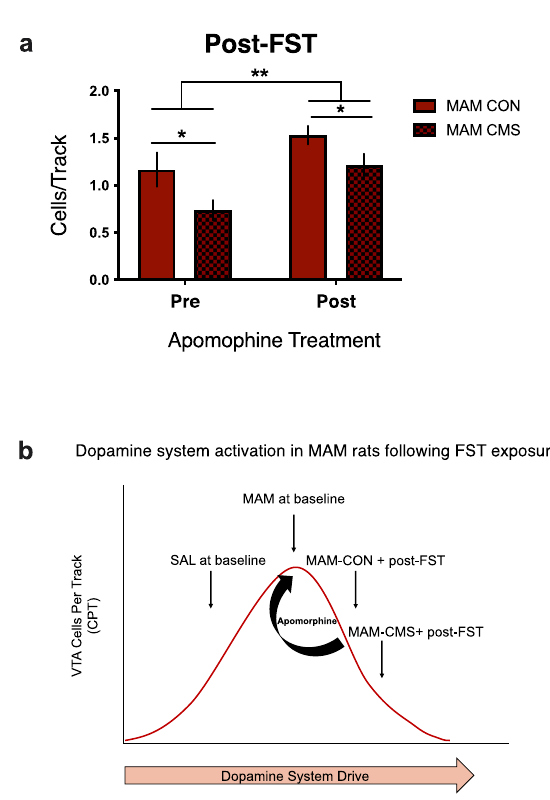
Fig. 4 FST exposure eliminates increased VTA population activity in MAM rats compared to SAL rats. a At baseline, MAM-CON rats exhibited elevated numbers of DA cells/track compared to SAL-CON and both CMS groups (two-way ANOVA: main effect of MAM ( p < 0.01) and adult CMS ( p < 0.0001), n = 6 – 9 per group). b After FST and AIH exposure, there was no difference between SAL and MAM rats in both CON and CMS conditions, although both SAL-CMS and MAM-CMS rats exhibited blunted VTA population activity compared to SAL-CON and MAM-CON rats (two-way ANOVA; main effect CMS: p < 0.01; n = 7 – 9). c Post-FST only, both CMS groups (SAL-CMS, MAM-CMS) exhibited blunted VTA population activity compared to CON groups (SAL-CON, MAM-CON (two-way ANOVA; main effect CMS: p < 0.0001; n = 9 – 11). d At baseline, population activity was reduced along the medial tracks of the VTA in MAM-CMS rats compared to MAM-CON rats ( p < 0.05). e Post- FST and AIH, population activity was reduced along the central tracks of the VTA in MAM-CMS rats compared to MAM-CON rats ( p < 0.01). f Post-FST only, population activity was reduced along the central tracks of the VTA in SAL-CMS rats compared to SAL-CON rats ( p < 0.05). g No effect of MAM ( p = 0.31) or CMS ( p = 0.68) was found for fi ring rate at baseline. h No effect of MAM ( p = 0.71) or CMS ( p = 0.43) was found for fi ring rate post-FST and AIH. i Post-FST only, there was no effect of MAM ( p = 0.14) or CMS ( p = 0.58) for fi ring rate. j At baseline, no effect of MAM ( p = 0.37) or CMS ( p = 0.19) was found for burst fi ring. k No effect of MAM ( p = 0.62) or CMS ( p = 0.95) was found for burst fi ring